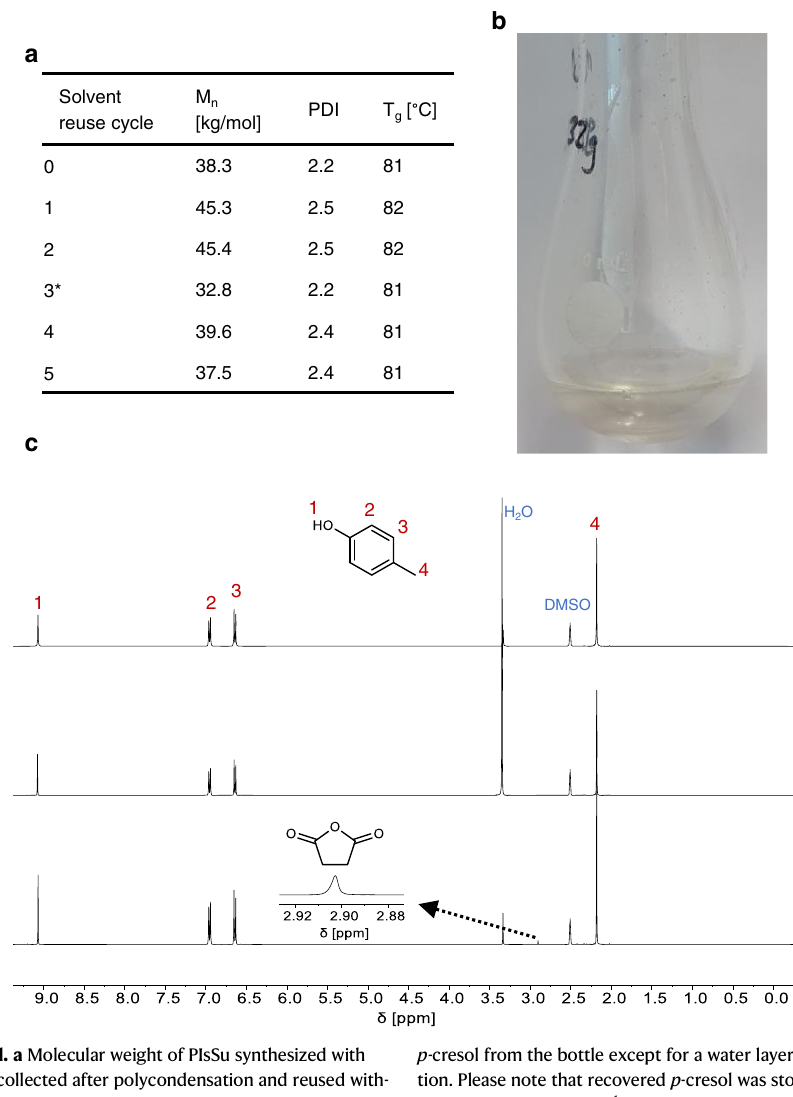
Fig. 4 | Reuseability of p -cresol. a Molecular weight of PIsSu synthesized with recycled p -cresol. p -Cresol was collected after polycondensation and reused with- out further puri fi cation. After fi ve reuse cycles of p -cresol, no signi fi cant change in the molecular weight of the fi nal product was observed. Differences in molecular weight can arise due to the very high melt viscosity of PIsSu, which can prevent stirringinthelast30minofhighvacuumpolycondensation.*Aleakoccurredinthe reactor setup during high vacuum, which resulted in a lower molecular weight. b Picture of p- cresol after 5 reuse cycles. No change in appearance was visible to